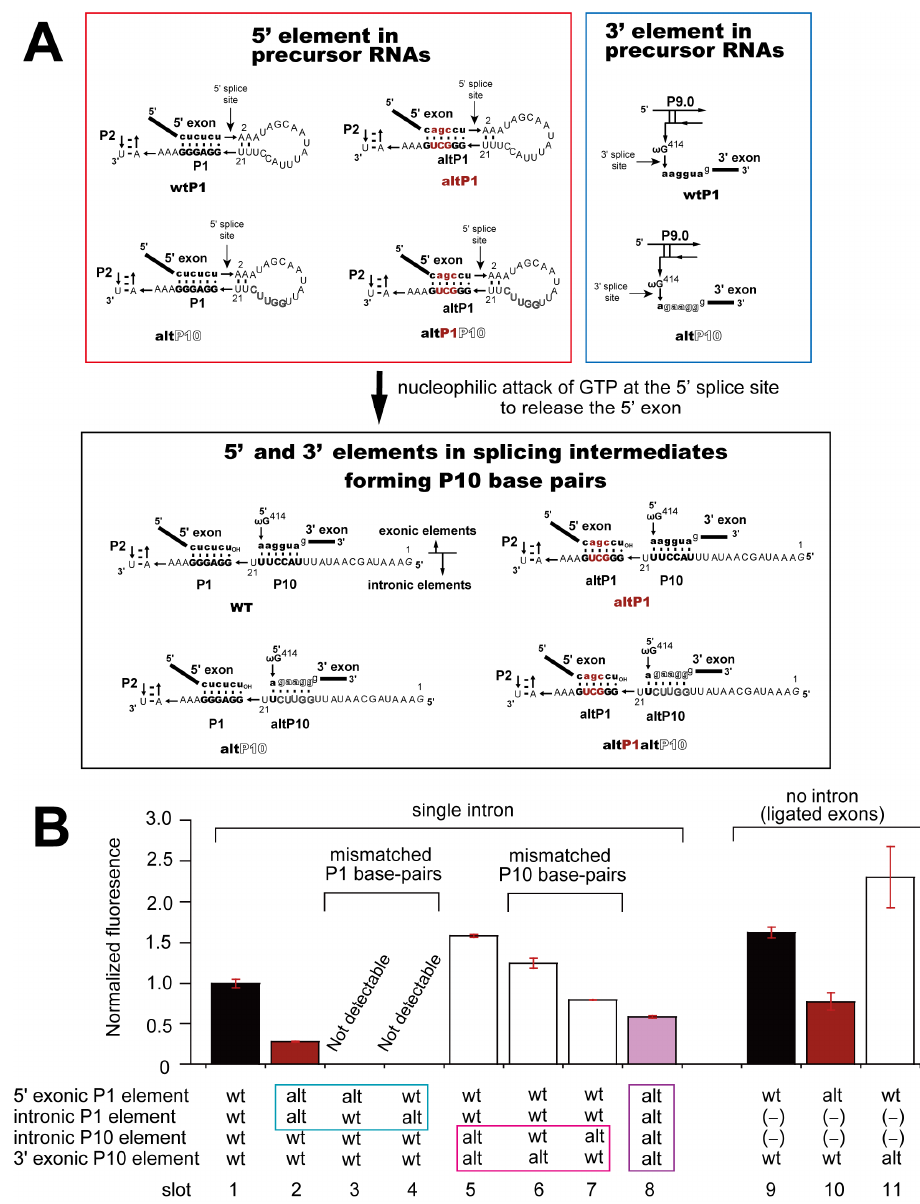
Figure 7. Rational engineering of the 5′ and 3′ splice sites to distinguish two introns. ( A ) The 5′ and 3′ elements of the WT intron ribozyme and its variants are shown in red and blue boxes, respectively. P10 base pairs formed in splicing intermediates by their 5′ and 3′ elements are shown in the black box. ( B ) β-Galactosidase reporter gene assays to evaluate the splicing activities of eight precursors with single introns possessing the WT and variant P1 and P10 elements. Expression of the lacZ-α fragment from the ligated exons yielded by variant P1 and P10 elements was also measured.